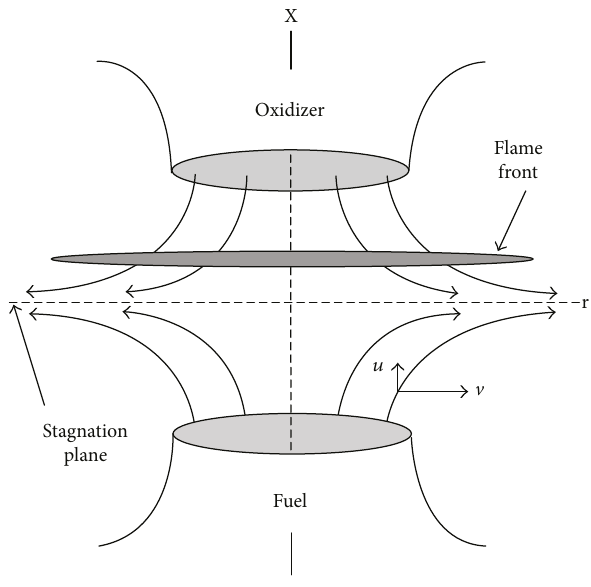
Figure 1: Schematic view of a counter fl ow fl ame. Table 1: Geometric dimensions and boundary